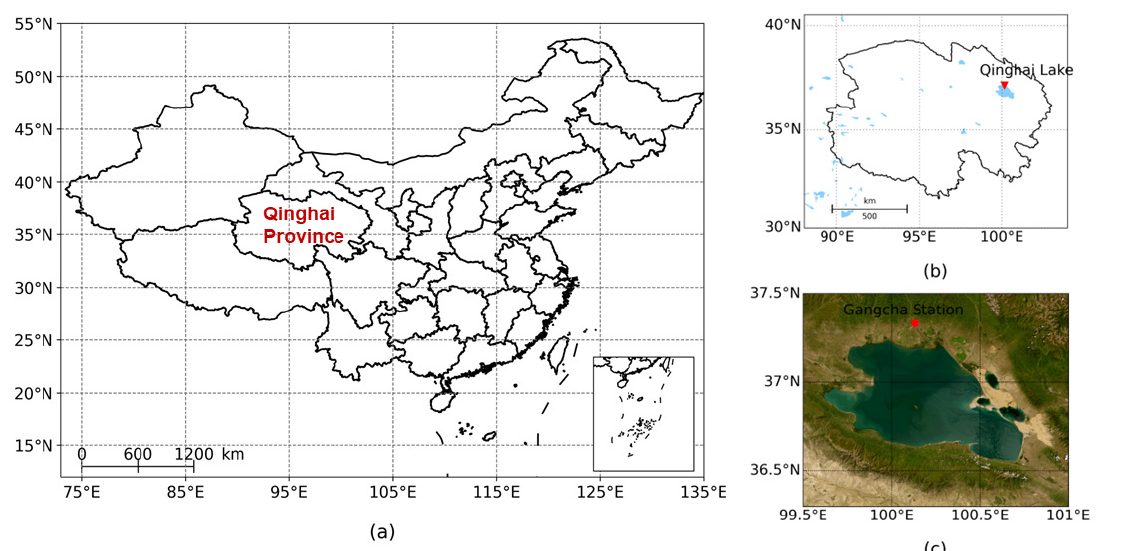
Figure 3. Location of the area studied in this paper. ( a ): Location of Qinghai Province in China. ( b ): Location of Qinghai lake in Qinghai province. The red mark is Qinghai Lake. ( c ): A satellite map of Qinghai Lake. The red circles represent the locations of the Guncha meteorological